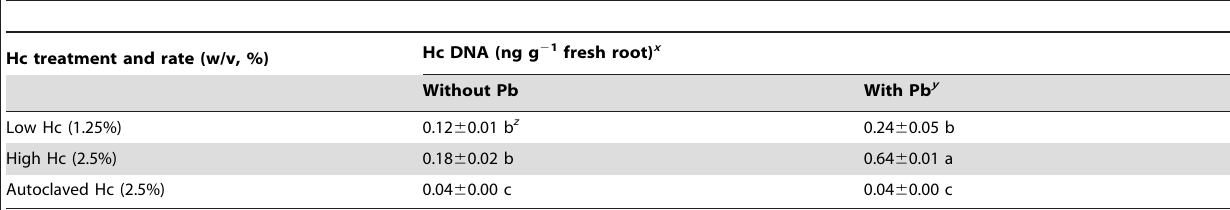
Table 2. Colonization of canola roots by Heteroconium chaetospira strain BC2HB1 (Hc) based on qPCR, with or without inoculation with Plasmodiophora brassicae